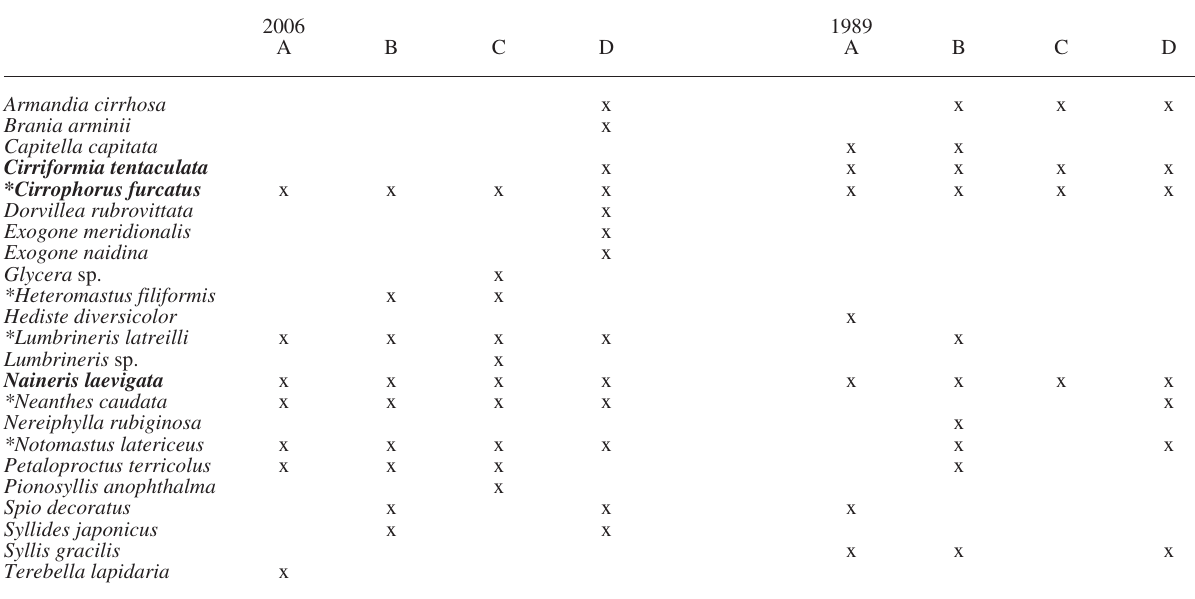
Table 4. – Presence/absence matrix of the polychaete species collected in July 1989 and July 2006 at the 4 analysed sites (* species dominat- ing assemblages in July 2006; in bold the species dominating assemblages in July